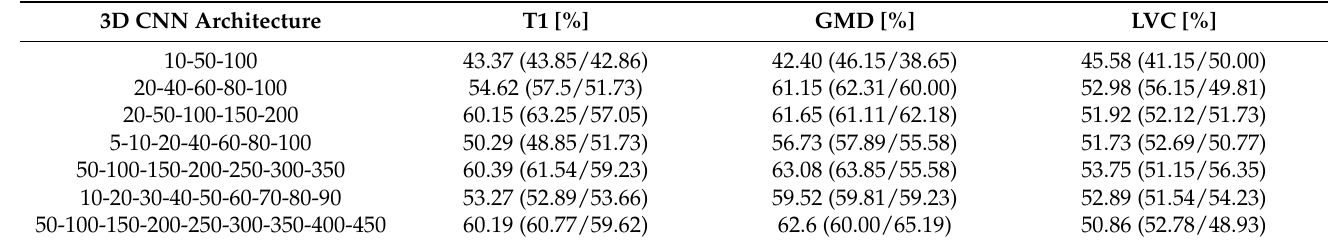
Table 4. Results for 3D CNNs learned on the three types of features (T1, GMD, and LVC). The metrics listed represent the accuracy (sensitivity/specificity) in